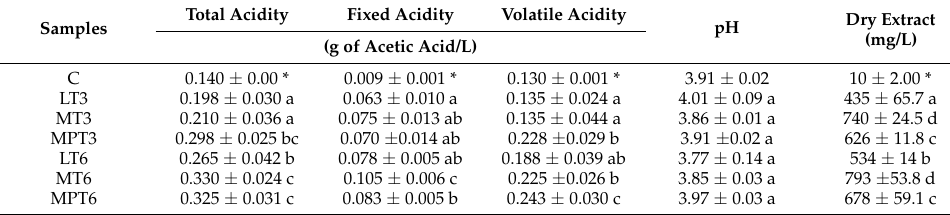
Table 1. ANOVA results and mean values of acidity, pH, and dry extract of the AUS aged with oak. Total Samples